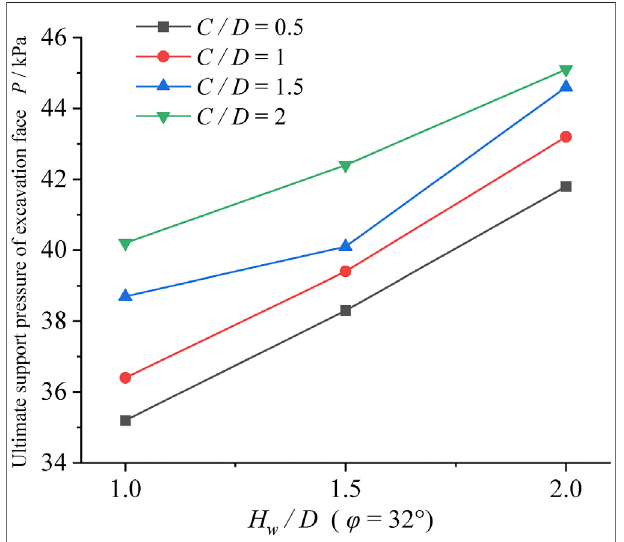
FIGURE 8 | Relationship between limit support pressure and height of water head of tunnel.